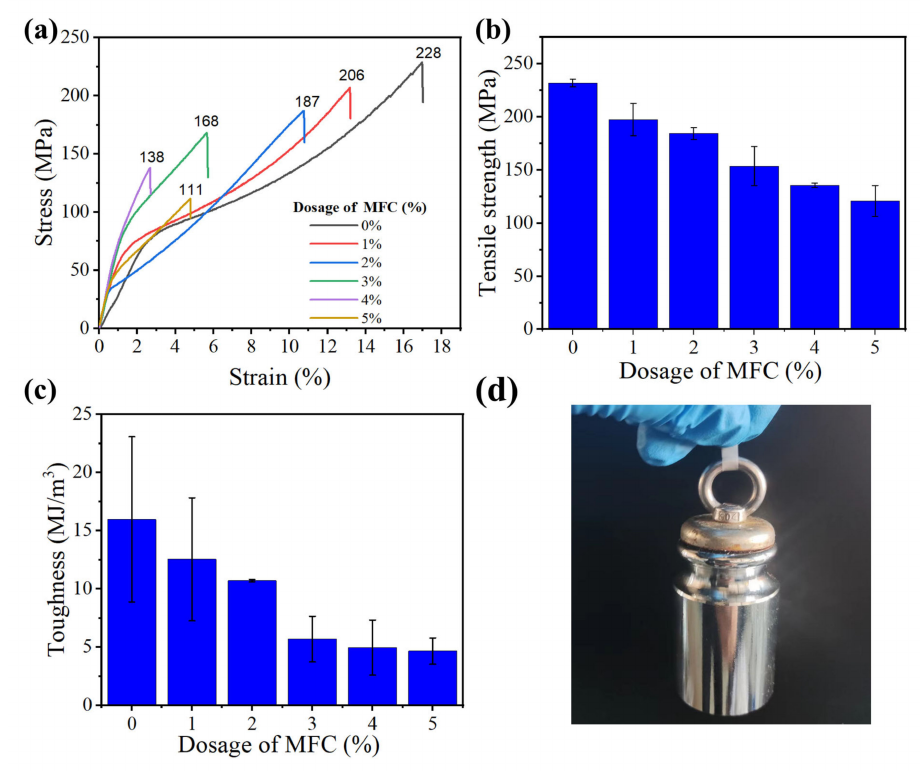
Figure 5. Stress–strain curves ( a ), tensile strength ( b ), and toughness ( c ) of films. ( d ) The composite film (3 wt.% MFC) can pull up 500 g weights.